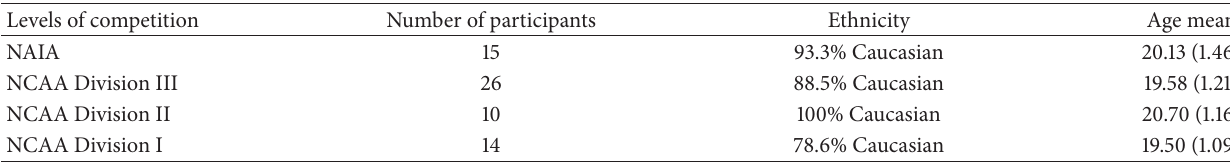
Table 1: Demographic